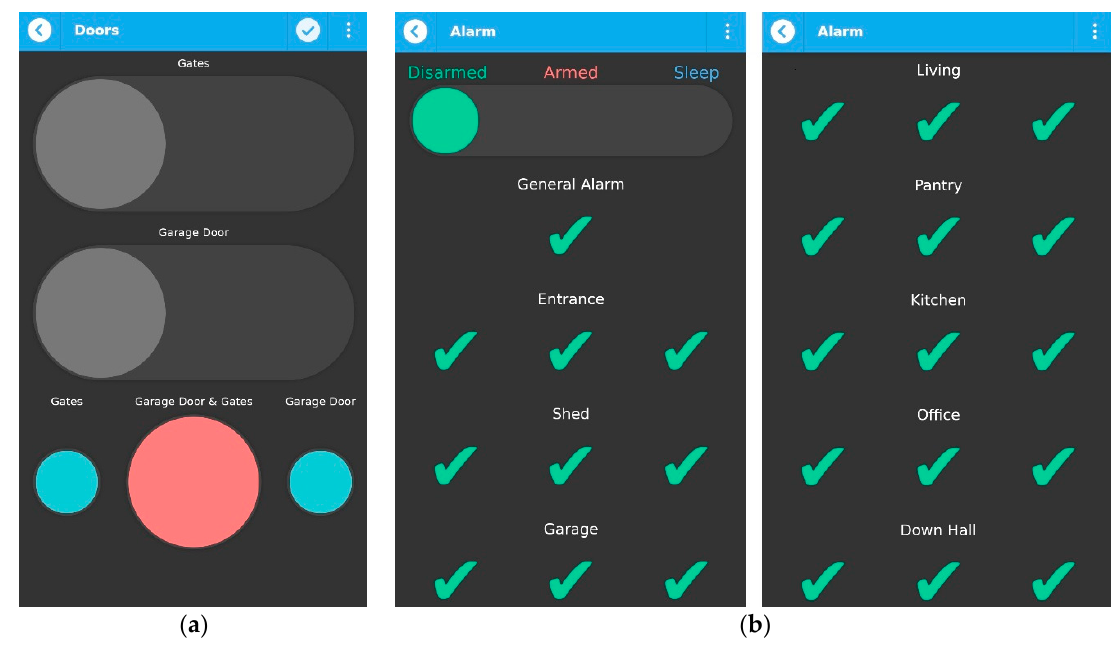
Figure 12. Access control ( a ) and security ( b ) with qToggle.